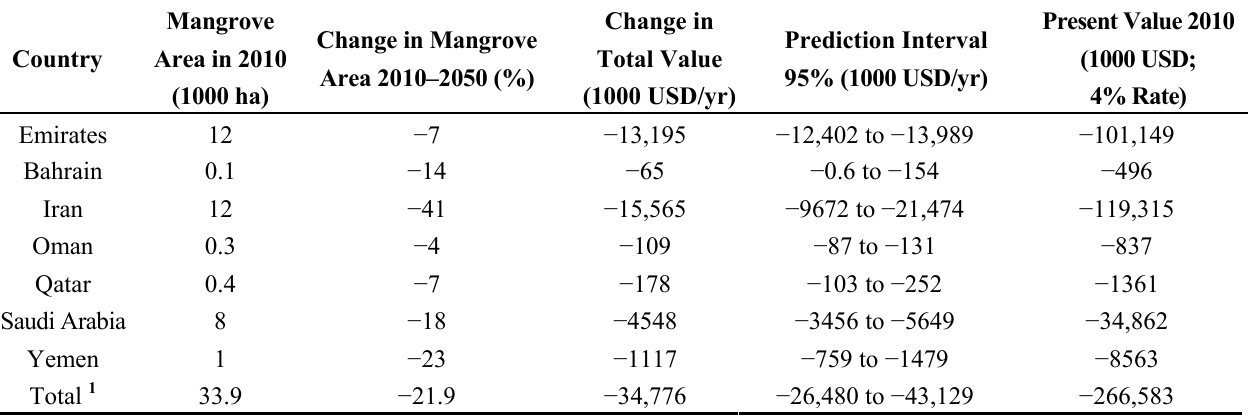
Table 2. Change in mangrove area and value in West Asia by country